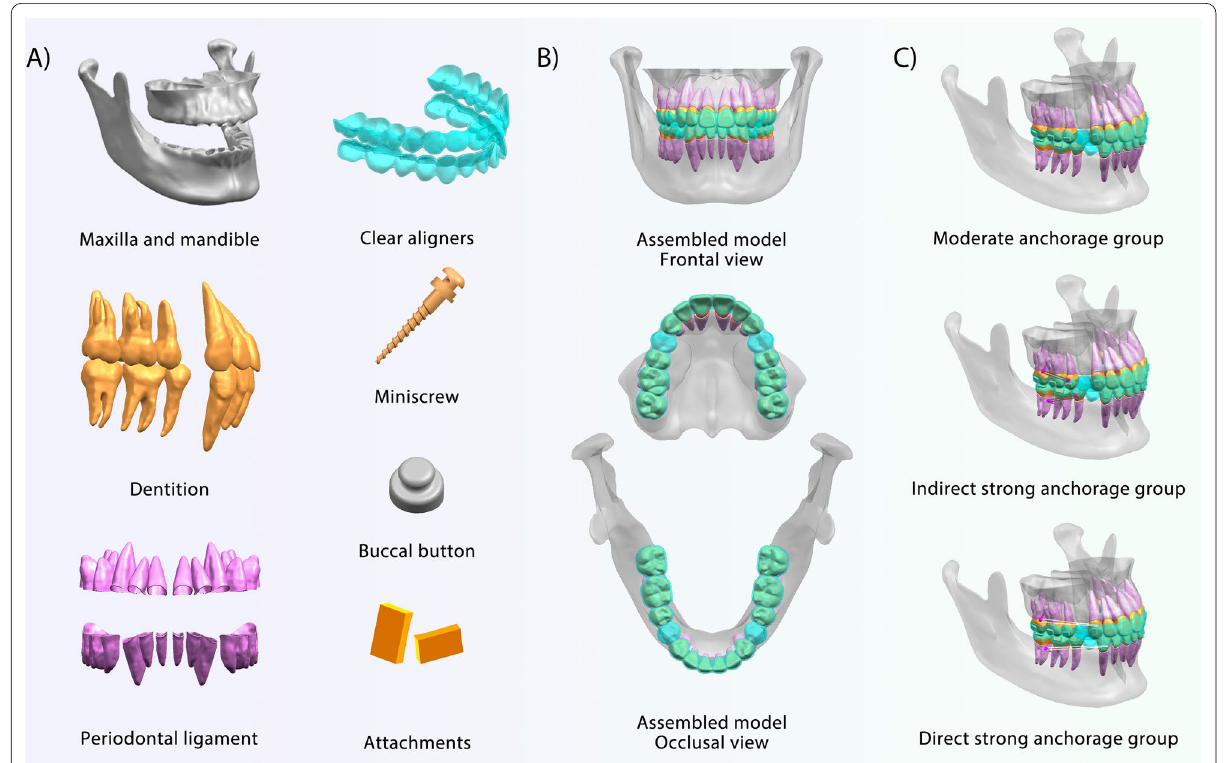
Fig. 1 Models for the finite element analysis. A The bimaxillary tissues were generated according to patient data, and the clear aligners, attachments, miniscrew, and buccal button were constructed based on available products. B The assembled research model in different views. C Three groups of different anchorage were constructed: the moderate anchorage group was used as a control group to the two strong anchorage groups. Indirect strong anchorage group: the second premolars and miniscrew were ligated together with metallic ligation wire. Direct strong anchorage group: the elastic force was applied to the canine region of the CA with the assistance of